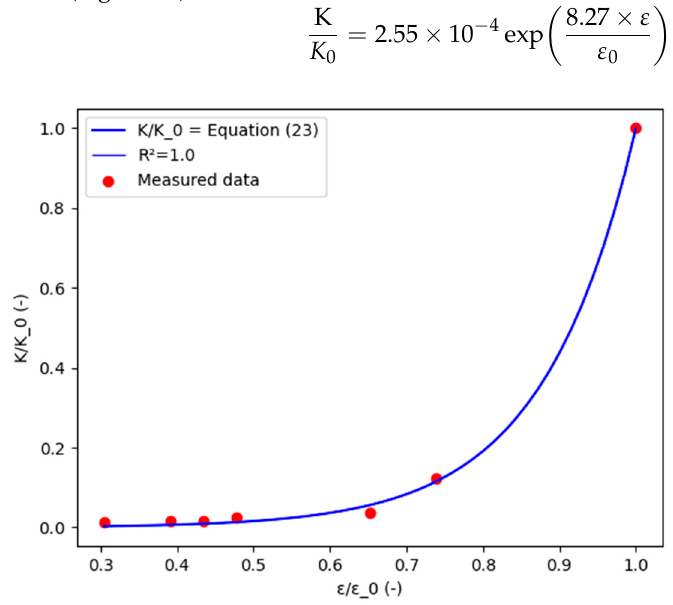
Figure 12. Variation of moisture transfer coefficient with the compressed MCC PH101 powder tablet porosity.